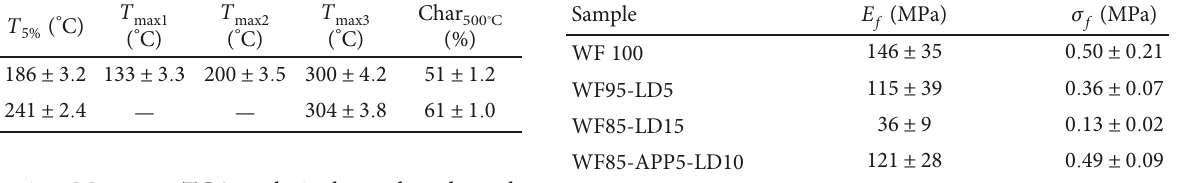
Table 3: Main fl exural properties of WFP.